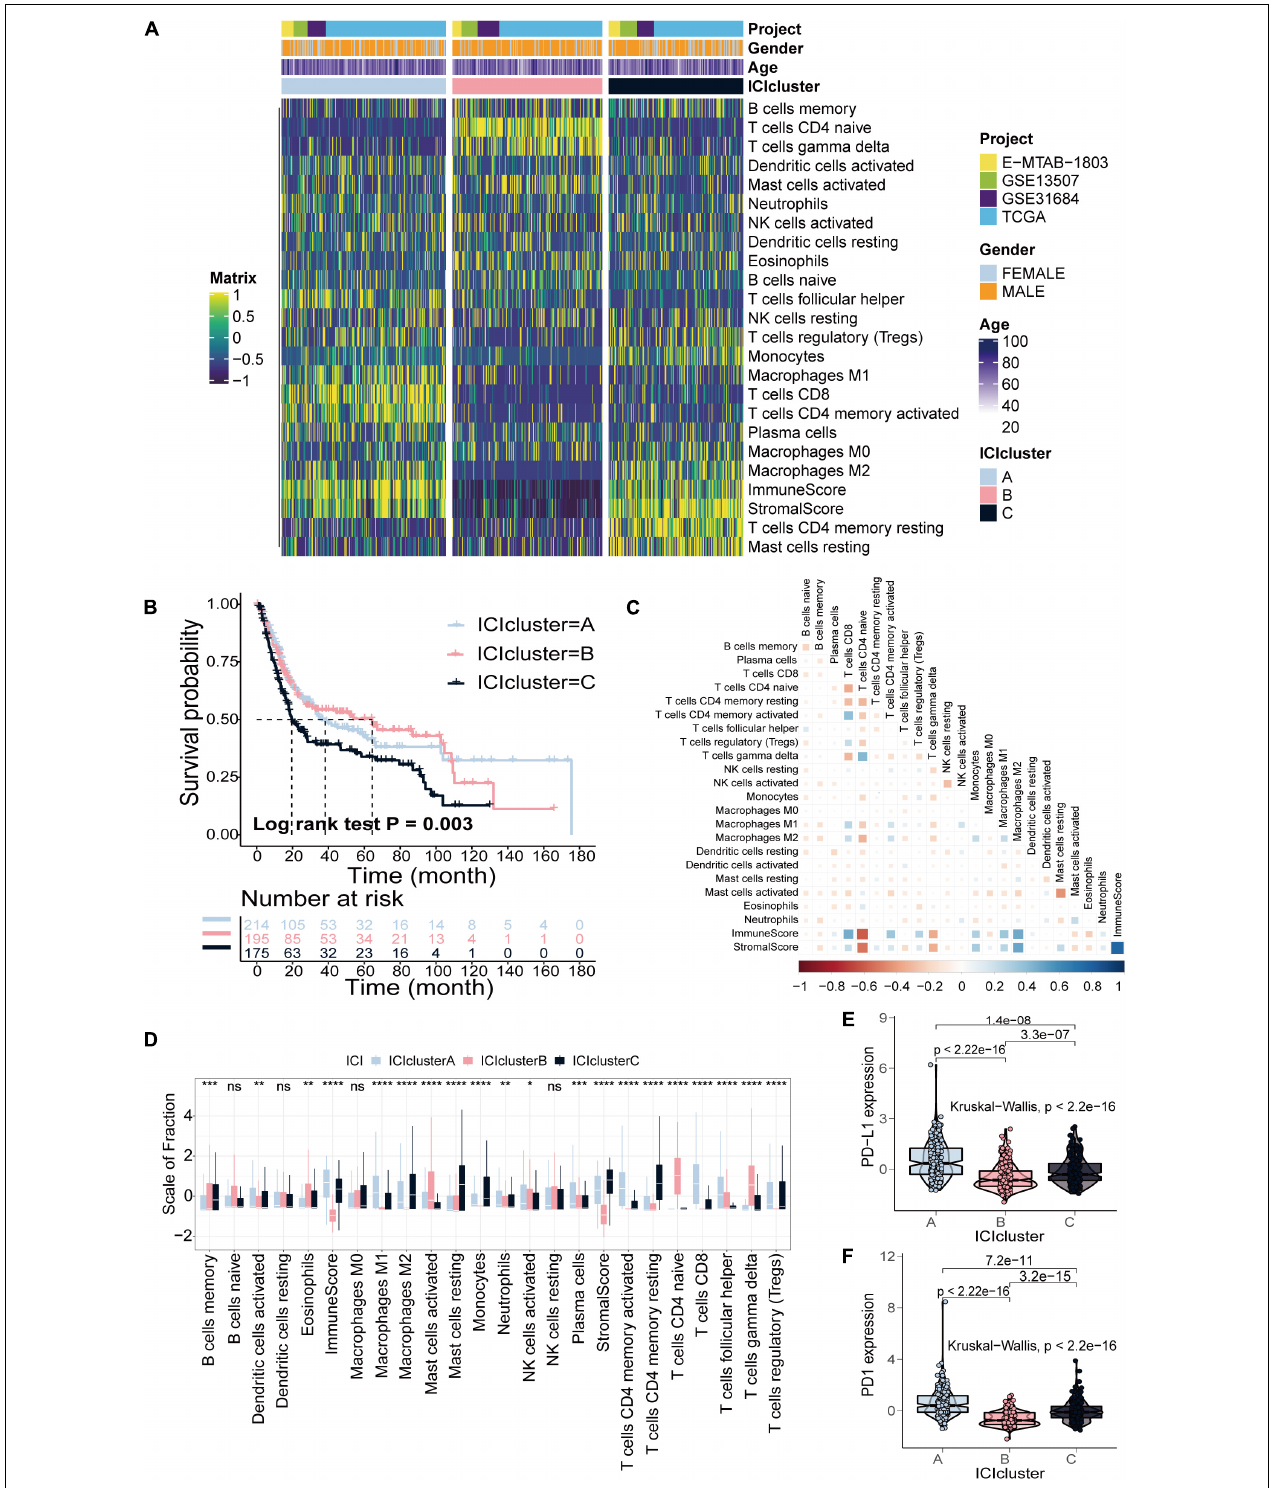
FIGURE 1 | Identification of ICI subtypes in bladder cancer. (A) Consensus clustering of TIICs in four BLCA cohorts. (B) Kaplan–Meier curves for OS of all BLCA patients with ICI clusters (log-rank test, p = 0.003). (C) Cellular interaction of the TIICs types. (D) The fraction of TIICs, immune score and stromal score in three ICI clusters (Kruskal–Wallis test, * p < 0.05; ** p < 0.01; *** p < 0.001; **** p < 0.0001). (E,F) The difference in PD-L1 (E) and PD-1 (F) expression among three ICI clusters (Kruskal–Wallis test, p < 2.2e-16).